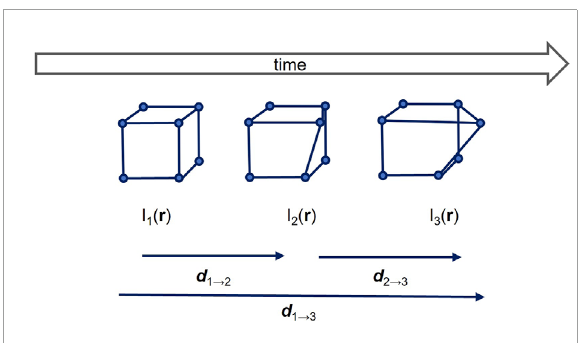
FIGURE 1 Schematic overview of the multi-frame method, with number of frames equal to